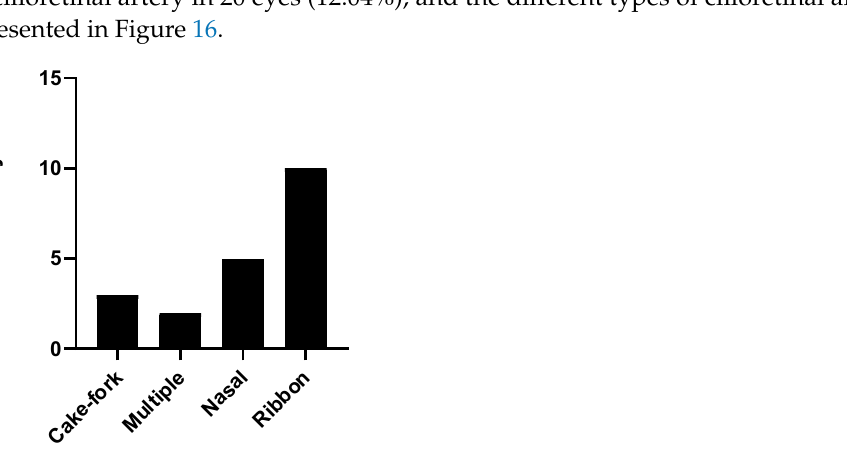
Figure 16. Number of eyes with each type of cilioretinal artery.